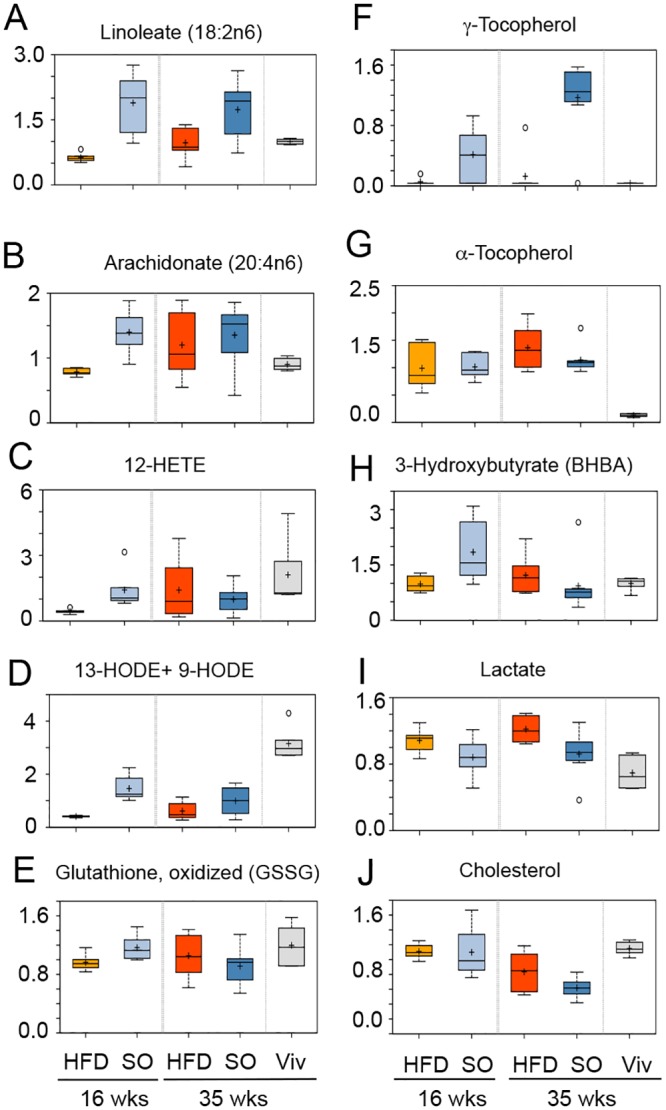
Hepatic metabolite levels change with diet and over time.Box-plots of liver metabolomics data from male mice fed the indicated diets for 16 or 35 weeks showing changes in levels of A) Linoleic acid, B) Arachidonic acid, C) 12-HETE, D) 13 HODE +9 HODE, E) Glutathione, oxidized, F) γ-Tocopherol, G) α-Tocopherol, H) 3-Hydroxybutyrate, I) Lactate, and J) Cholesterol. At 16 weeks SO-HFD is significantly different from HFD for all metabolites except γ-tocopherol, lactate and cholesterol. At 35 weeks there is no statistical difference between SO-HFD and HFD except for linoleic acid, γ-tocopherol and lactate; cholesterol is approaching significance. Significance, P ≤ 0.05; approaching significance, 0.05 < P < 0.10 by Welch’s two sample t-test. (See S4 Dataset for additional box plots.)